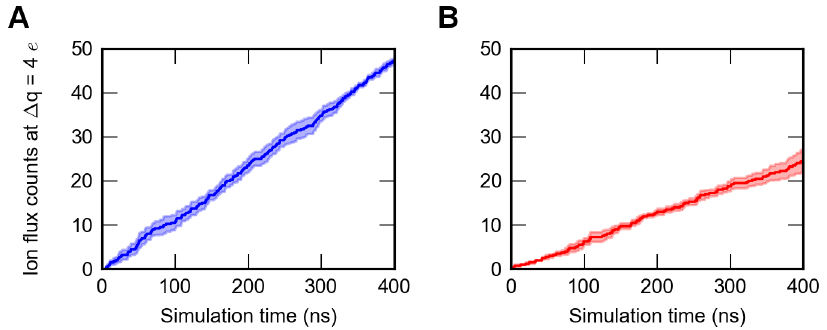
Figure 1. Ion flux in double bilayer simulations without dihedral restraints on E53 (n=4). A) Average ion flux count of inward conduction through the SF over time (color: blue). B) Average ion flux count of outward conduction through the SF over time (color: red). Error estimations shown in the figure are S.E.M.